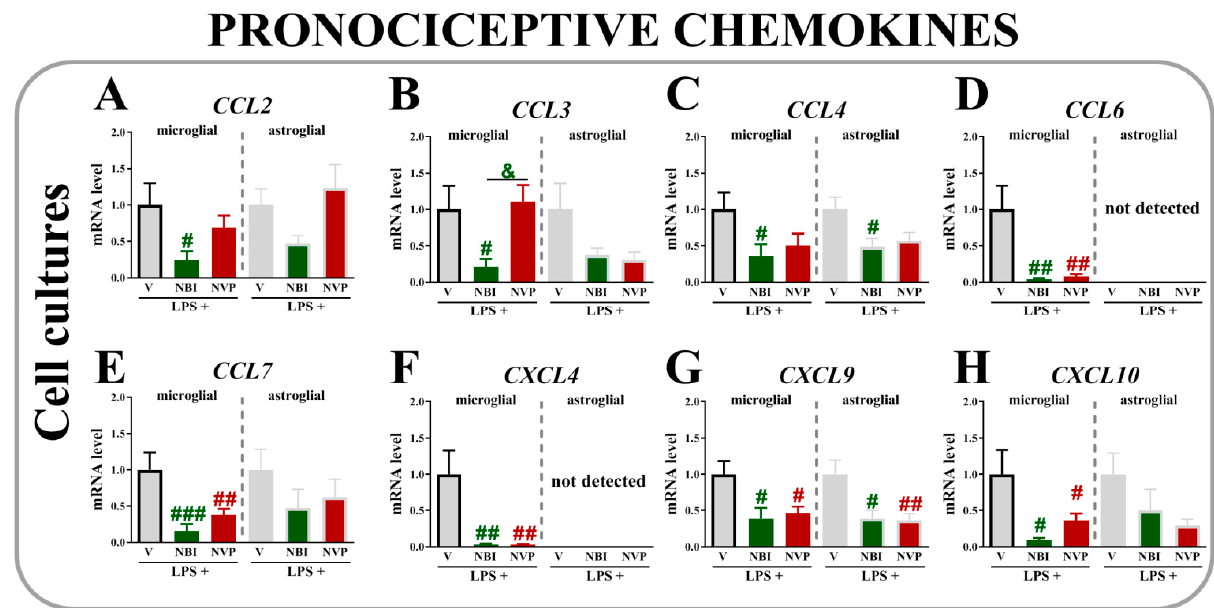
Figure 7. Comparison of the effects of (±)-NBI 74330 and NVP CXCR2 20 (100 nM; each; ( A – H) ) on the mRNA levels of select chemokines (CCL2, CCL3, CCL4, CCL6, CCL7, CXCL4, CXCL9, and CXCL10) in microglial (left panel) and astroglial (right panel) cell cultures. The RT-qPCR data are presented as the means ± SEM (3–4 independent experiments). The results were evaluated using one-way ANOVA followed by Bonferroni’s test. # p < 0.05; ## p < 0.01 and ### p < 0.001 for the comparison of vehicle-treated LPS-stimulated cells with all groups. & p < 0.05 for the comparison of NBI with NVP groups. Abbreviations: vehicle, V; (±)-NBI 74330, NBI; NVP CXCR2 20, NVP; lipopolysaccharide, LPS. LPS+, LPS-stimulated cells; LPS-, LPS-nonstimulated cells.